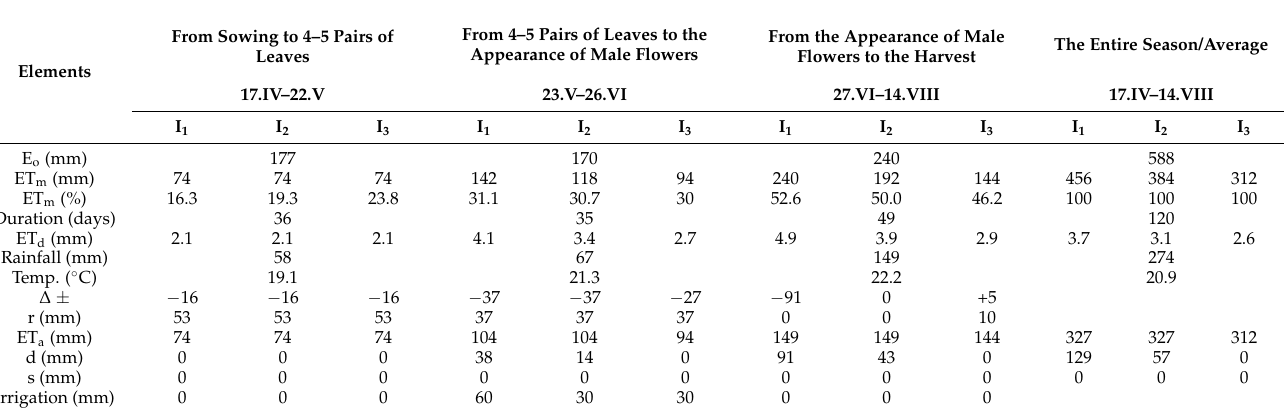
Figure 3. Irrigation water applied, mean daily air temperature (°C), and daily precipitation (mm) in 2019. 3.2. Yield Data, Plant Height, and Fiber Chemical Composition In 2018, the highest bark yield (6.6 t ha − 1 ), biomass (56.7 t ha − 1 ), green stem (45.2 t ha − 1 ), Table 3. Water budget of fiber hemp in 2018. and dry stem (18.0 t ha − 1 ) yields were detected for the I 3 variant. The plant height was not affected by irrigation. All studied elements had statistically significantly higher values for the non-topped variant compared to the topped one. Statistically significant differences in the fiber yields between RS 1 and RS 2 were not found (Table 5). The highest yield of hemp